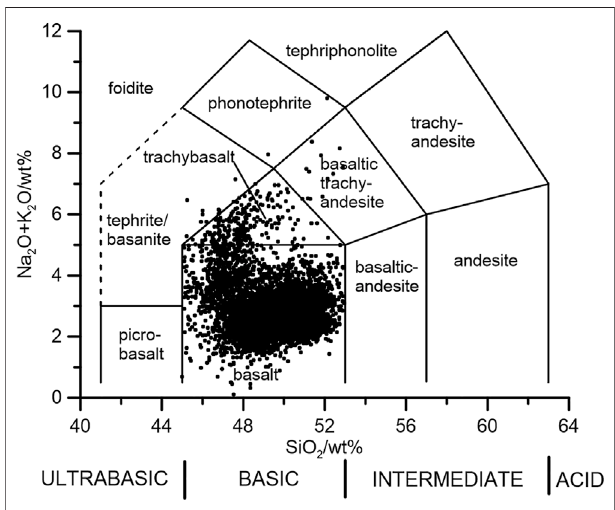
FIGURE 2 | TAS classi fi cation of samples collected from the MAR.